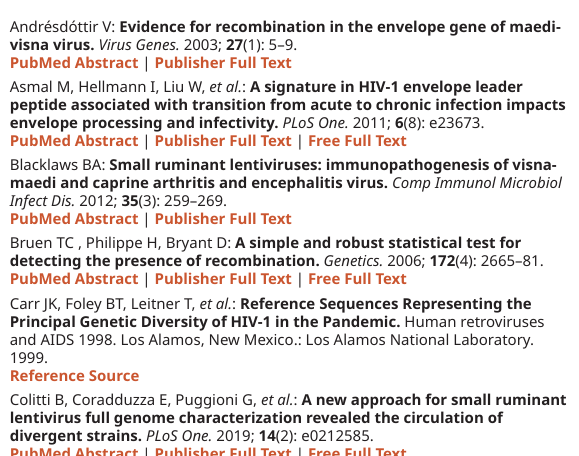
• Supplemental Table 5: Within-host amino acid vari- ability (functional viral quasispecies) at 106 subgroup diagnostic loci. Colors according to subgroup 1 vs sub- group 2 recombination model (Figure 4) can be seen in the downloaded file. 1. https://doi.org/10.6084/